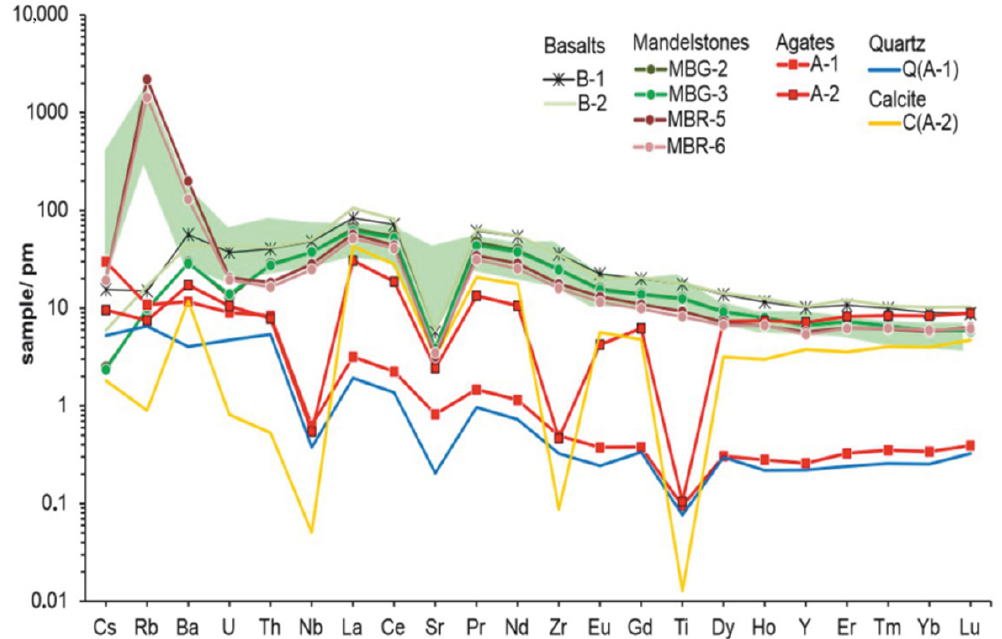
calcite samples extracted from agates) and host volcanic rocks of the Priozersk Formation. The normalization values are from [23]. Green field: the composition of the Late Permian High-Ti continental rift basalts in the Songpan–Ganzi Terrane (South China Block) [35].